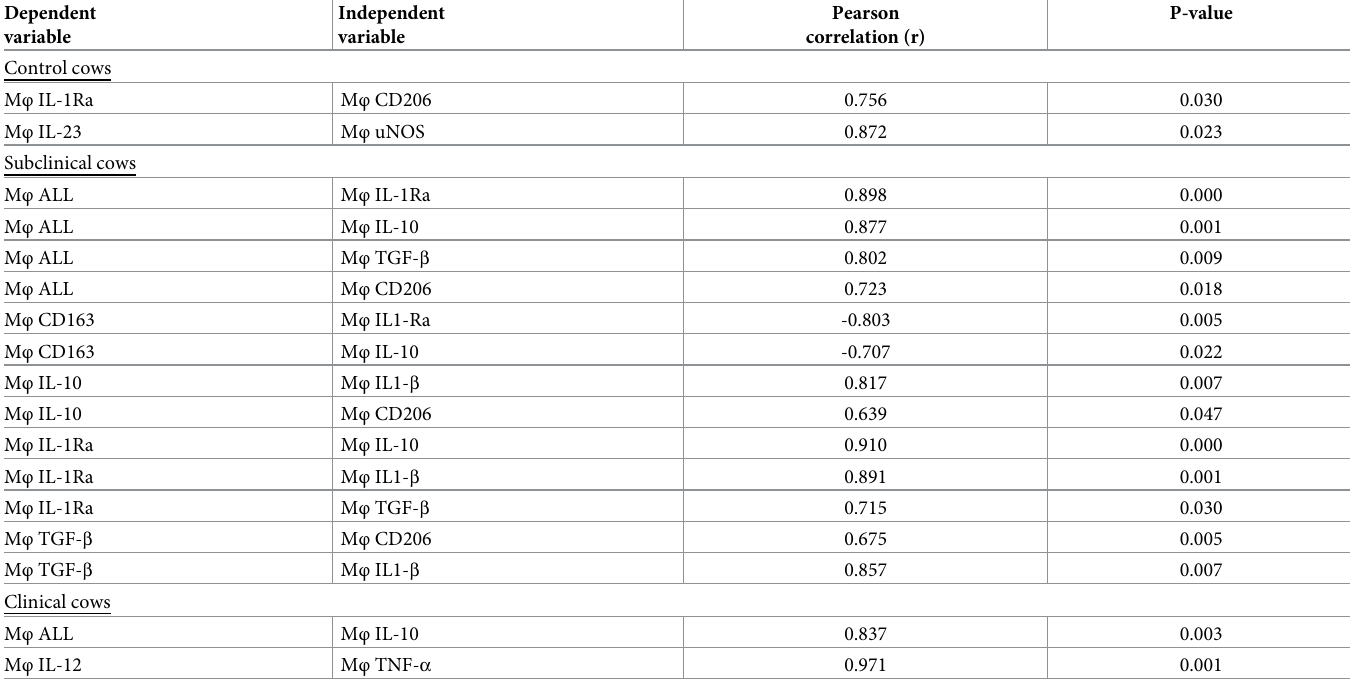
Table 4. Pair-wise Pearson correlations between cytokines colocalized within resolution and repair macrophage